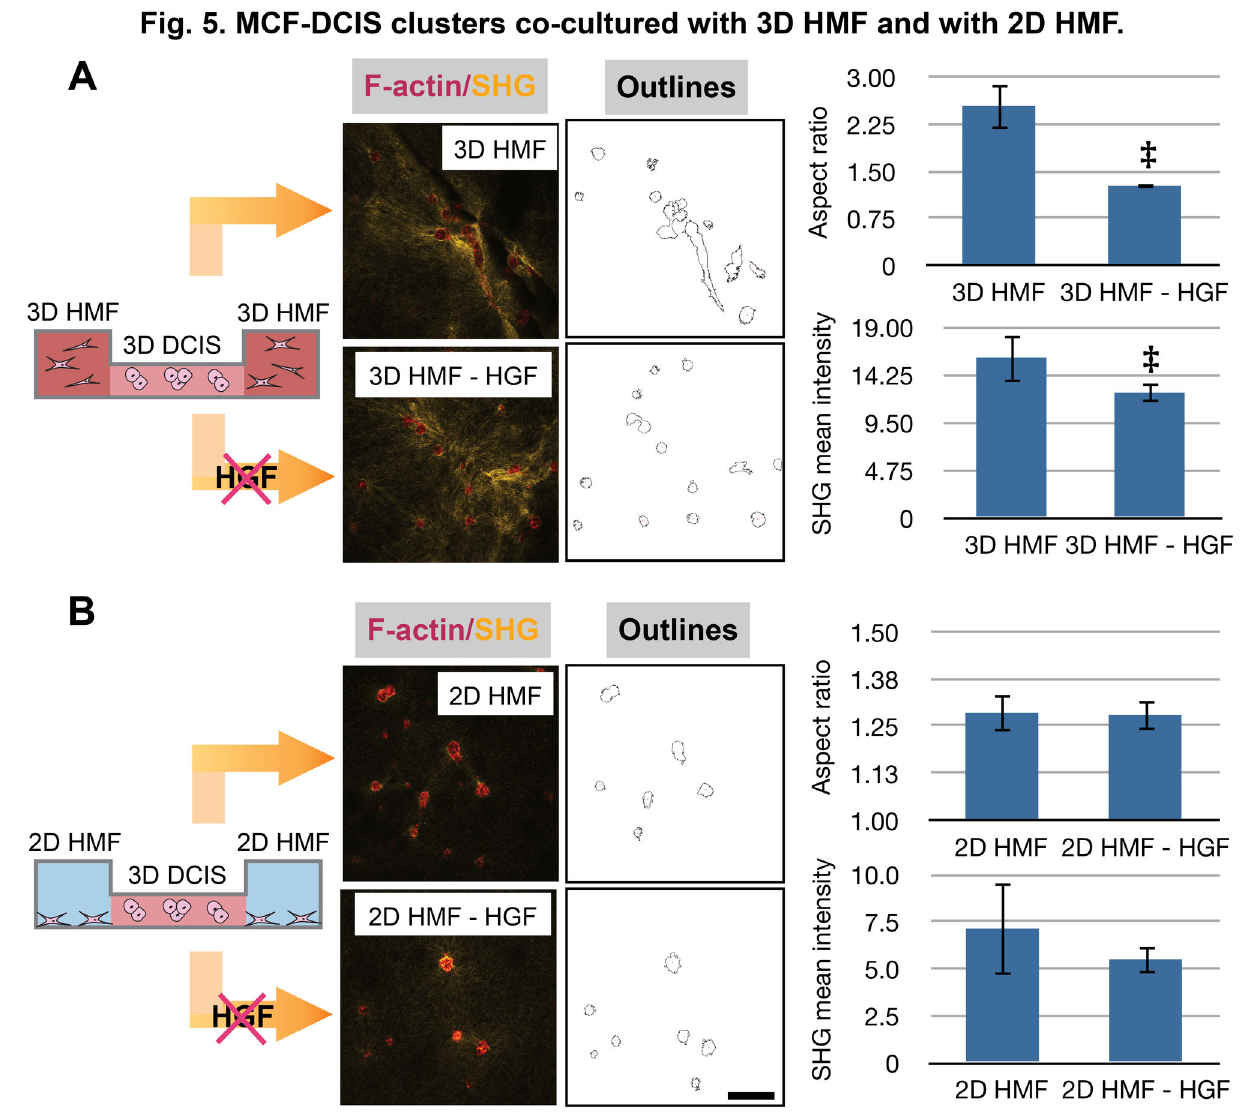
Figure 5. MCF-DCIS clusters co-cultured with 3D HMF and with 2D HMF. (A) MCF-DCIS clusters (red and outlines) co-cultured with 3D HMF and neutralizing HGF antibody at 0.5 μg/ml (3D HMF-HGF). SHG (yellow) shows changes in collagen architecture around MCF-DCIS cells. The addition of HGF neutralizing antibody significantly decreased the aspect ratio of MCF-DCIS cells and the mean intensity of SHG. ‡ represents p value less than 0.05. (B) MCF-DCIS clusters (red and outlines) co-cultured with 2D HMF and neutralizing HGF antibody at 0.5 μg/ml (2D HMF-HGF). Scale bar is 100